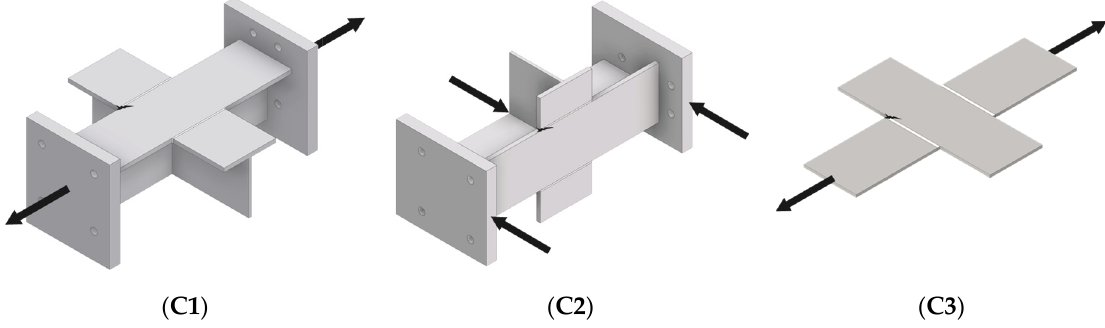
Figure 25. Specimen loading configurations for the full-scale component tests ( C1 , C2 ) and the half-scale component tests ( C3 ).